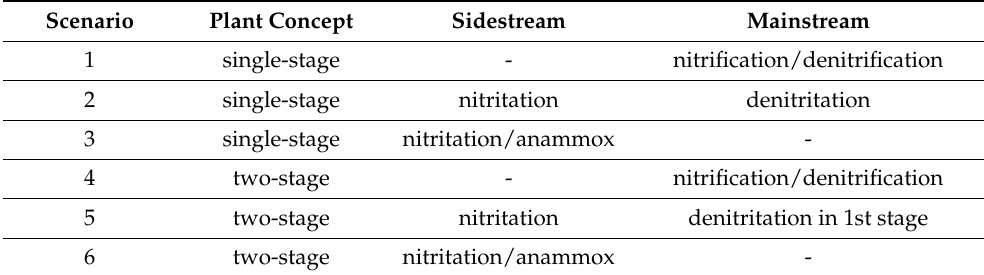
Table 2. Scenarios for the SDE treatment in single- and two-stage WWTPs.